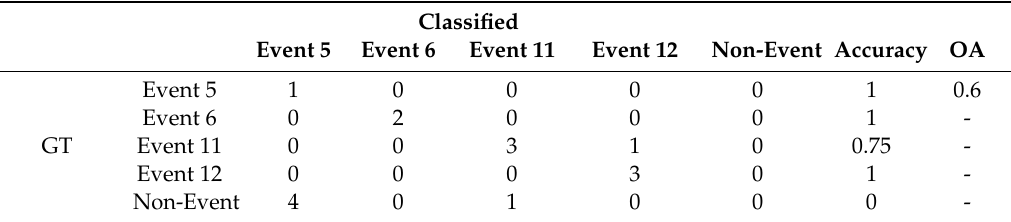
Figure 7. VIRAT_S_000102 Scene. This scene has both parking lot and building entrance events. Table 11. Event classification using the VideoGraph only approach for one VIRAT video: VIRAT_S_000102. The confusion matrix and OA are included.